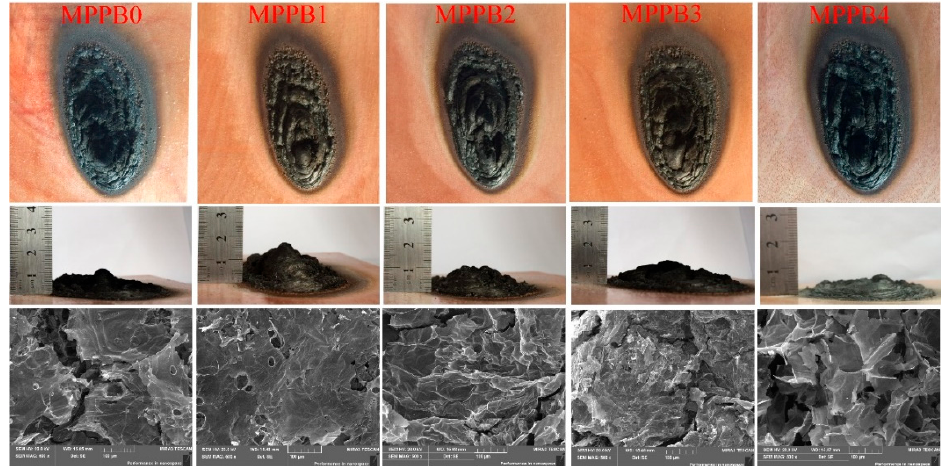
Figure 7. Digital photos and SEM images of char residue for each sample after the cabinet method